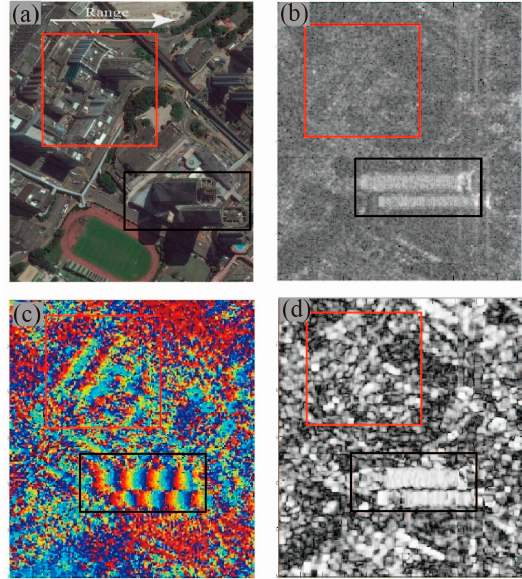
Figure 1. Building signals in an urban area: ( a ) buildings in optical images; ( b ) interferometric intensity data; ( c ) interferometric phase data; and ( d ) coherence.